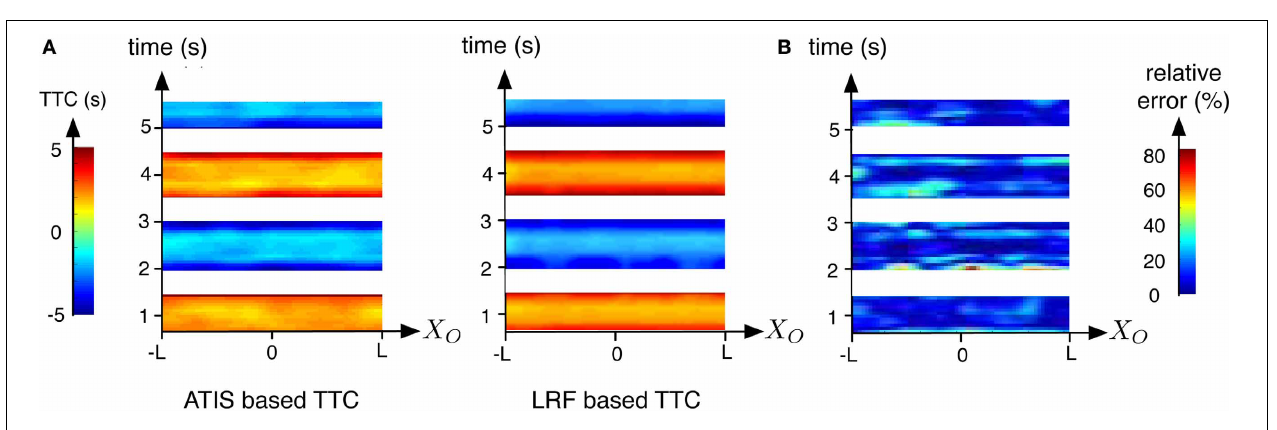
(A) TTC computed using the LRF (right) and the ATIS (left). (B) Relative errors between bothTTC estimations. illustrated using a color map, blue to red for increasing